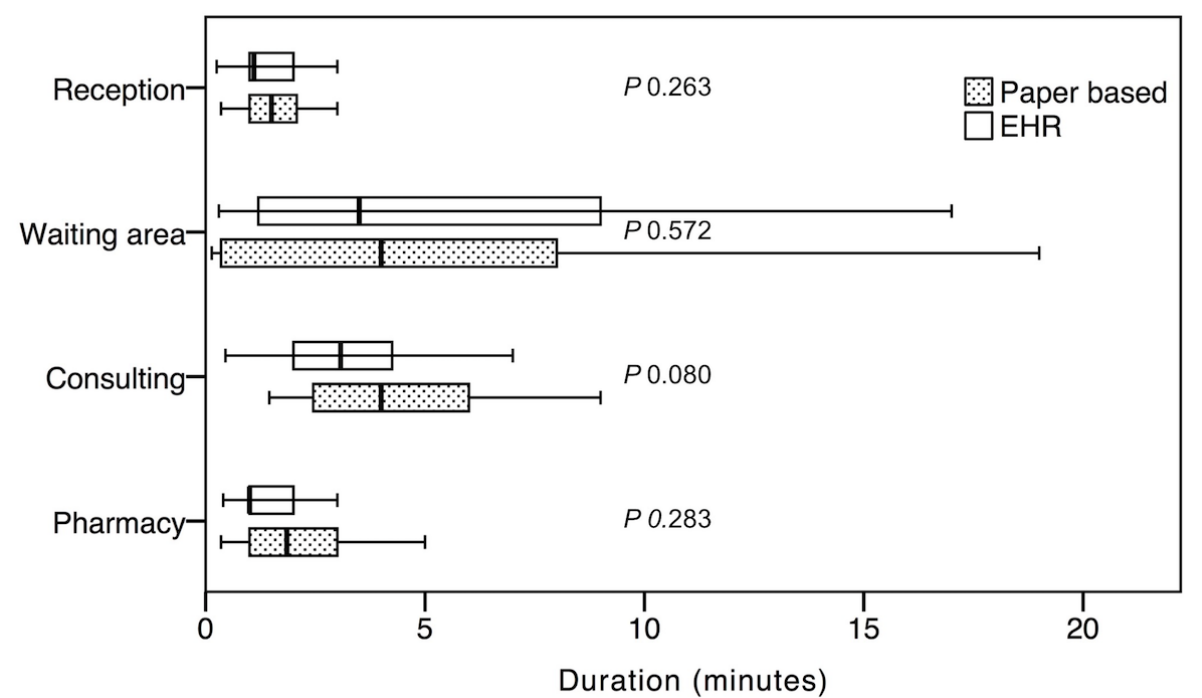
Figure 1. The time spent performing tasks at primary health care centers that use the electronic health record system and the paper-based system. EHR: electronic health record.